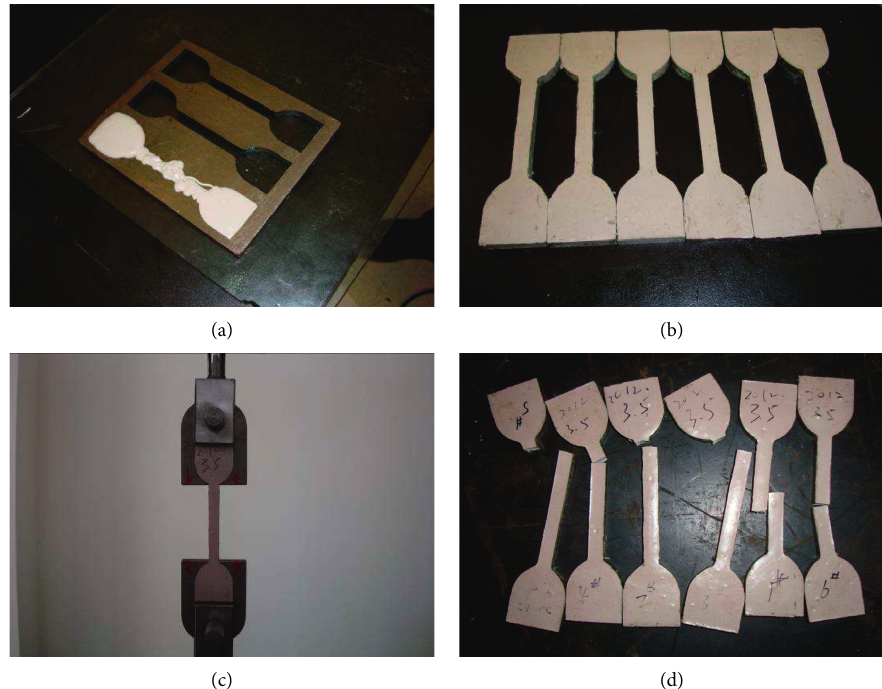
Figure 5: Dumbbell tensile test. (a) Dumbbell-shaped mold for specimen preparation; (b) dumbbell-shaped specimens; (c) tensile test apparatus; and (d) failed specimens.